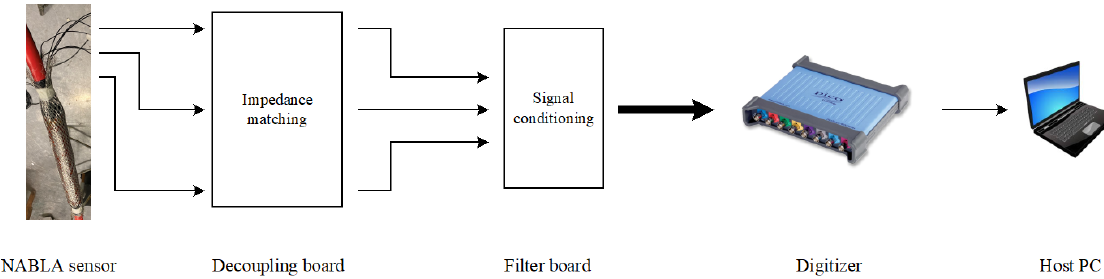
Figure 7. Block diagram of the measurement system.